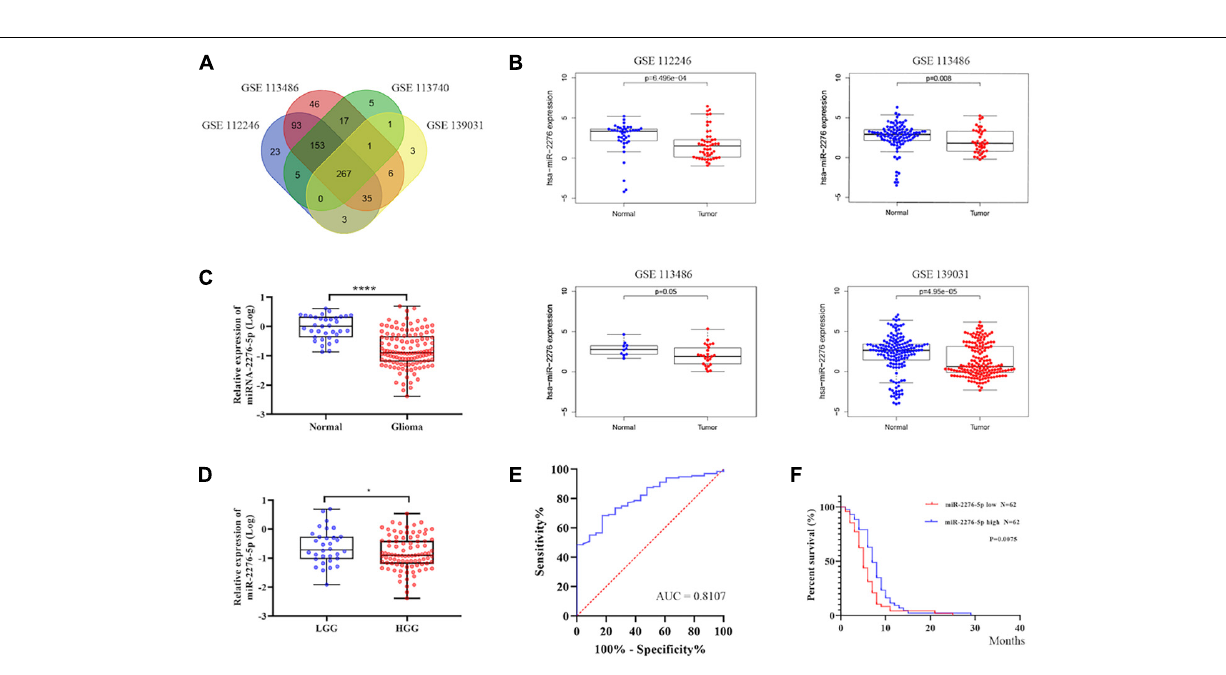
Frontiers in Cell and Developmental Biology |